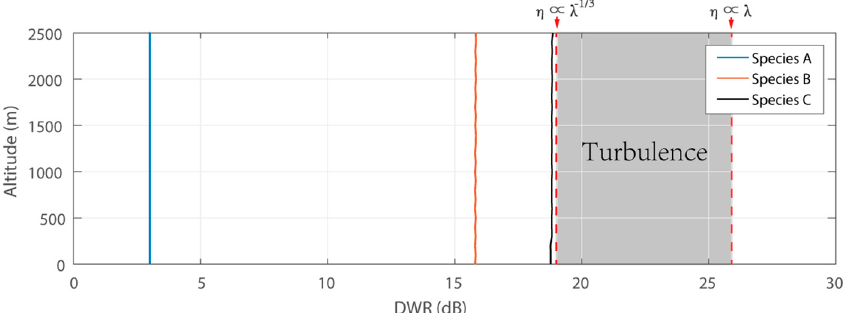
Figure 3. The simulated vertical profiles of the DWR between the S-band and X-band with the vertical height. The vertical profiles of turbulence fall in the grey-shaded area because of the different turbulence theories. The parameters of the three species are referenced from Table 1. All species are major agricultural pests in North China.